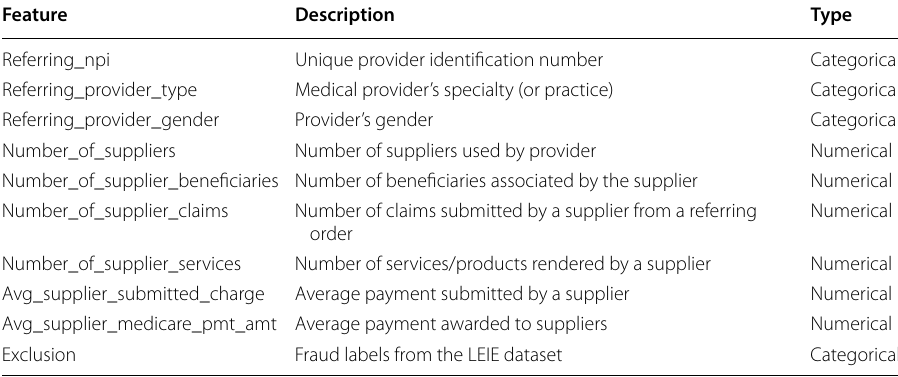
Table 8 Description of features chosen from the DMEPOS dataset